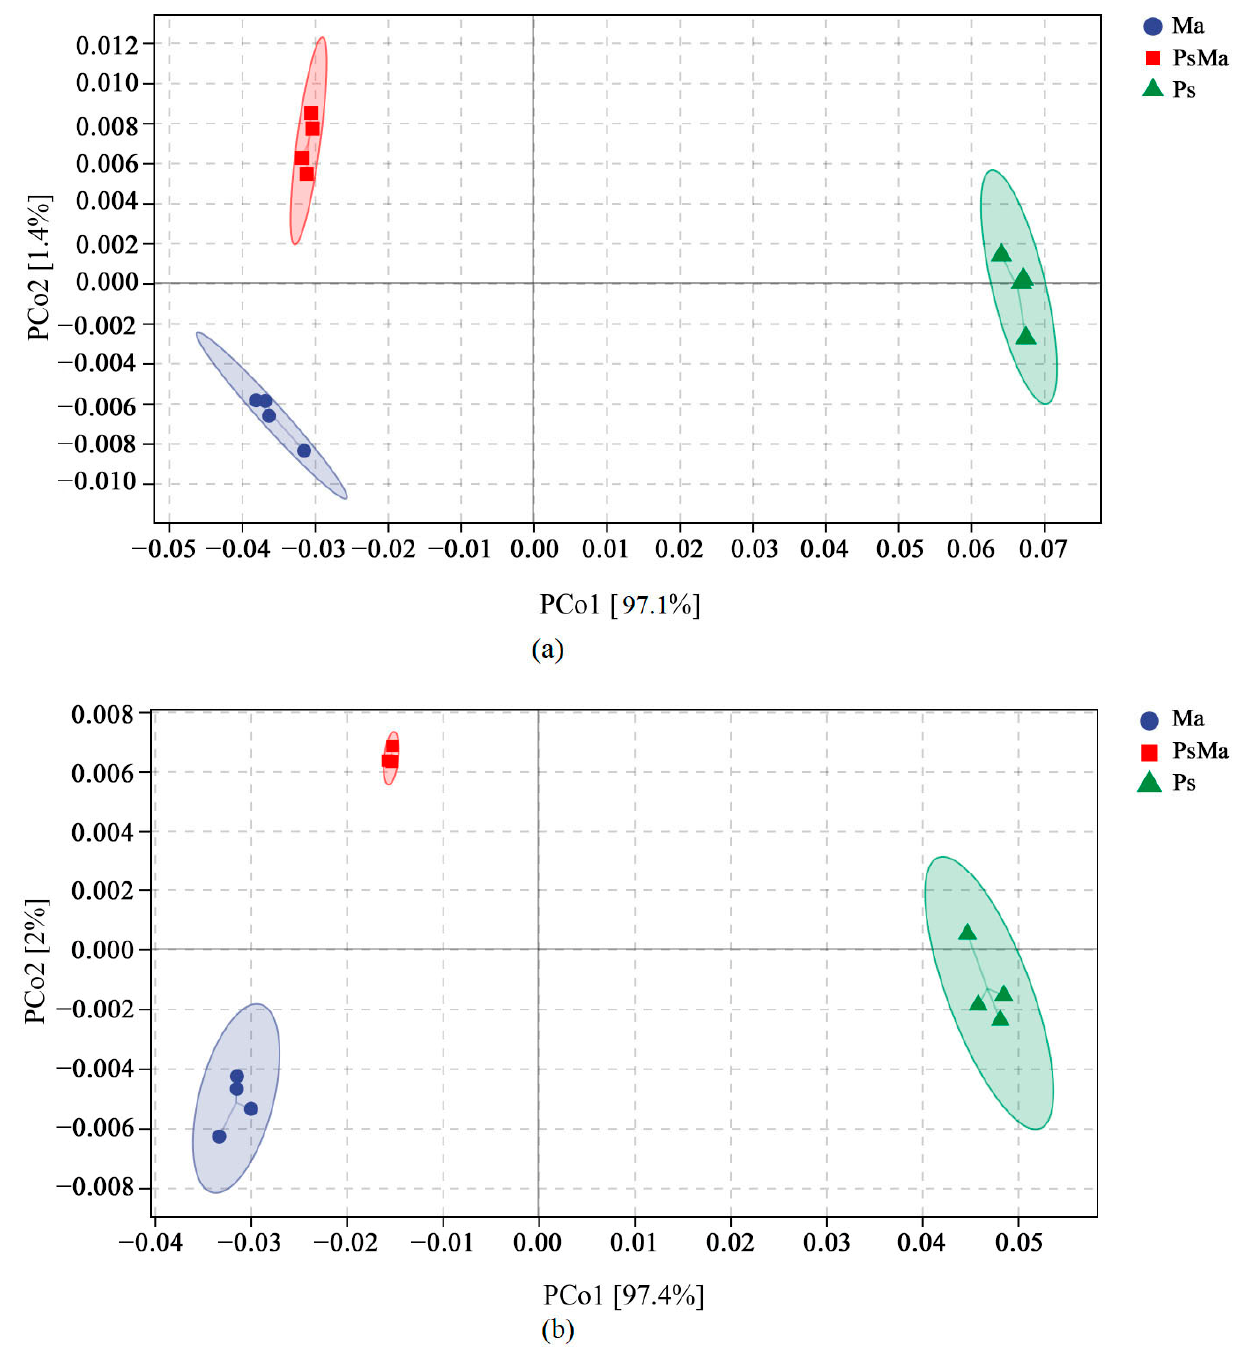
Figure 9. Functional unit PCoA analysis of different litters. ( a ): Functional unit PCoA analysis of bacterial communities with different leaf litter ratios; ( b ): Functional unit PCoA analysis of fungal communities with different leaf litter ratios. Ma: Morus alba ; PsMa: Pinus sylvestris var. mongolica × Morus alba ; Ps: Pinus sylvestris var. mongolica . The circle in the figure is the 95% confidence ellipse.